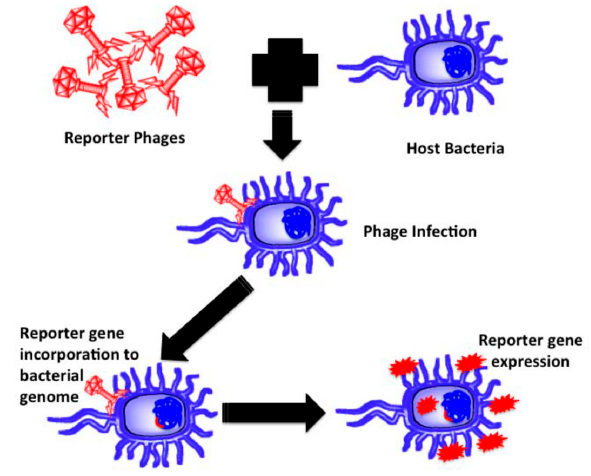
Figure 4. Detection of a pathogen by the phage-based method [69] .